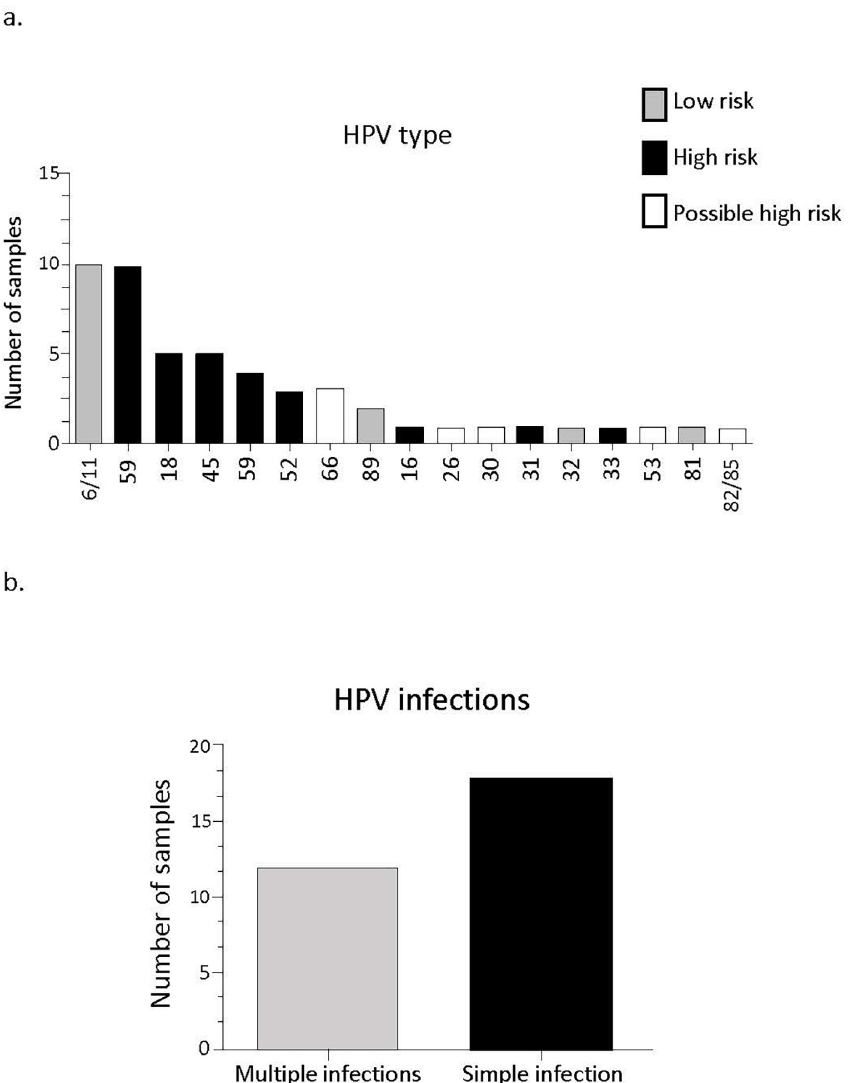
Fig 1. Viral genotyping and presence of multiple (by more than one viral type) or simple infections (by a single viral type) of samples from patients treated at Hospital de Amor, Campo Grande, MS, Brazil. (a.) Viral HPV types detected in samples with multiple or simple infections (n = 30) and (b.) Frequency of simple and multiple HPV infection (n = 30). 30 HPV DNA-positive patients (mean age 44.7 years). In the ECC samples, there was a signifi- cant increase in the concentrations of IL-17 (p = 0.011), IL-10 (p = 0.027), IL-6 (p = 0.000), and IL-4 (p = 0.002) among C . trachomatis DNA-positive samples when compared to those positive for HPV DNA. However, there was no significant difference in the levels of IFN- γ , TNF, and IL-2 (p > 0.05) between the two groups (Fig 2). When PB samples were assessed, higher levels of IL-4 (p = 0.020) and IL-2 (p = 0.001) were observed among C . trachomatis DNA-positive samples as compared to HPV DNA-positive samples. There was no significant difference in the levels of the other cytokines (p > 0.05) (Table 3).